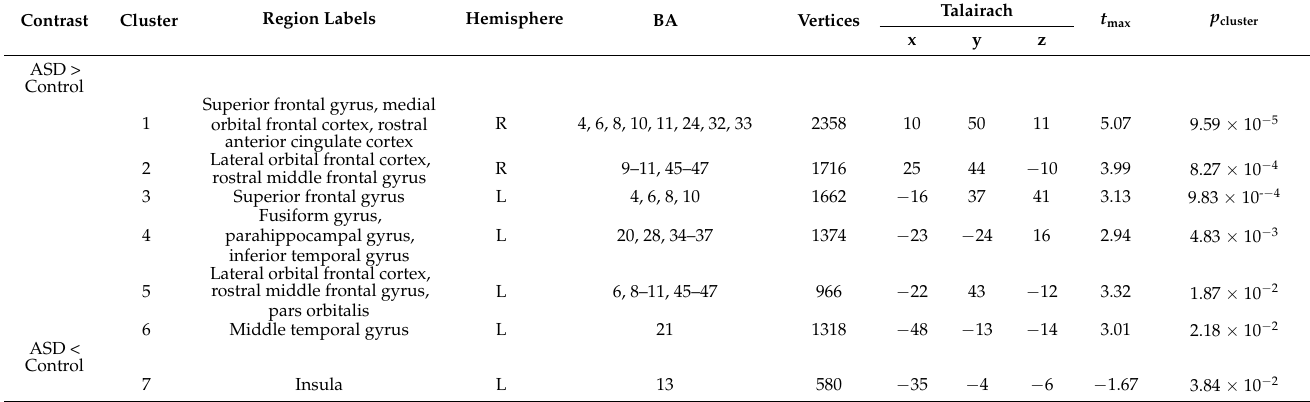
Table 2. Clusters with significant between-group differences in the estimated developmental change in cortical thickness (CT spc ) from T1 to